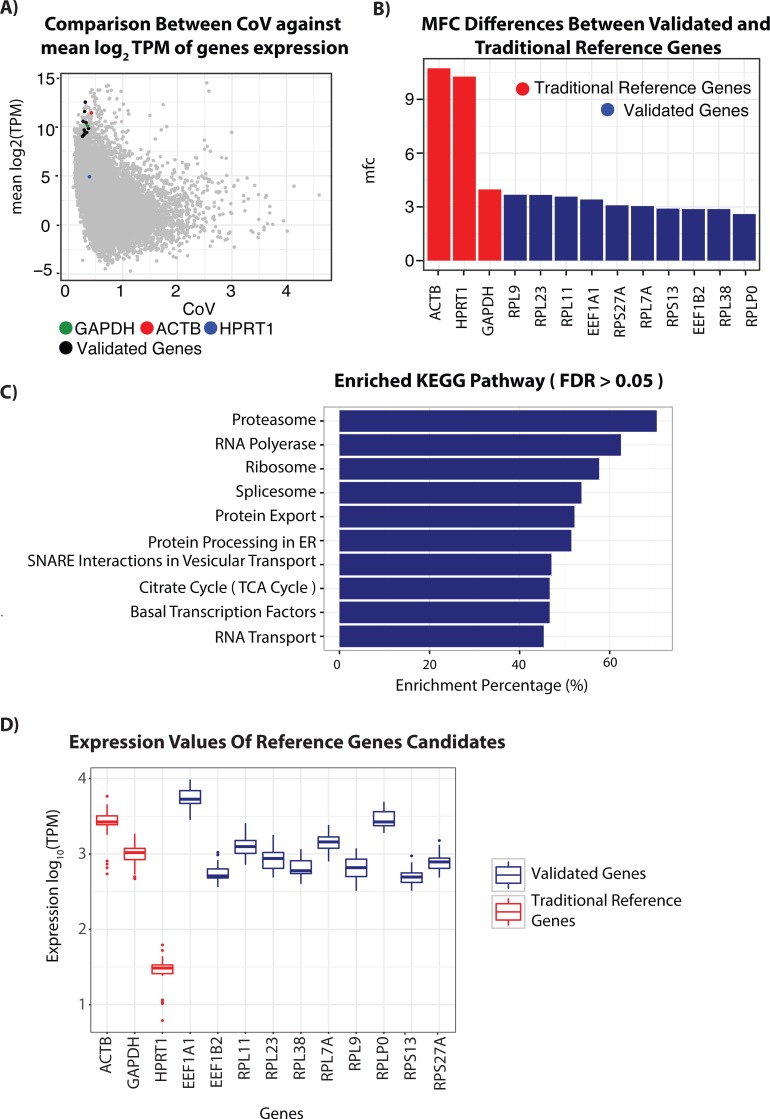
RNA-seq analysis of genes and candidate reference genes.(A) Scatterplot comparing Coefficient of variation (CoV) values against mean expression values (log2) transformed and represented in Transcript per kilobases million (TPM) for genes detected using the RNA-seq of patient derived skin samples. Each gene is represented by a single dot. Genes selected for validation to function as reference genes in non-melanoma skin cancers (NMSC) and precancerous lesions are shown in Black. Reference genes commonly used in the literature, ACTB (Red), GAPDH (Blue) and HPRT1 (Green), are also highlighted for comparisons. (B) Comparison of maximum fold change score in gene expression of candidate reference genes and traditional reference genes. (C) Results of KEGG pathway enrichment analysis conducted with a list of 3,714 genes found with product score between each gene’s MFC and CoV score below the lower quantile. Enrichment percentage is defined as the percentage of genes in the pathway that are overlaps with genes in our list. (D) Boxplot showing expression value from RNASeq experiment of 29 skin lesions of selected reference genes candidate (blue) with commonly used housekeeping genes ACTB, GAPHD and HPRT1 (red).